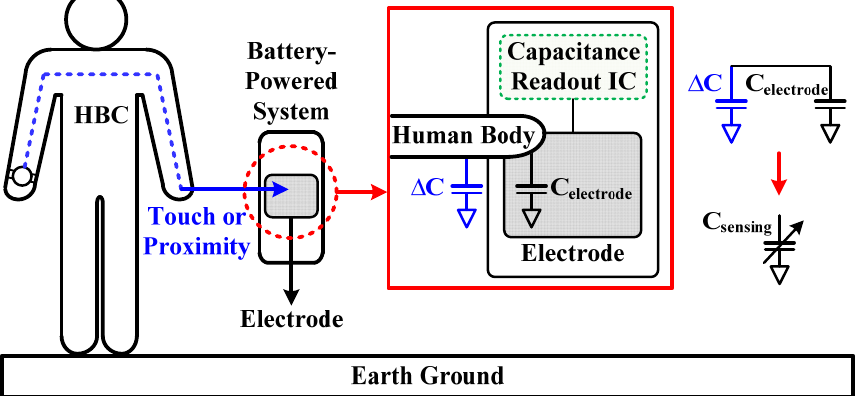
Figure 1. Capacitive coupling-based human body communication (HBC) systems.